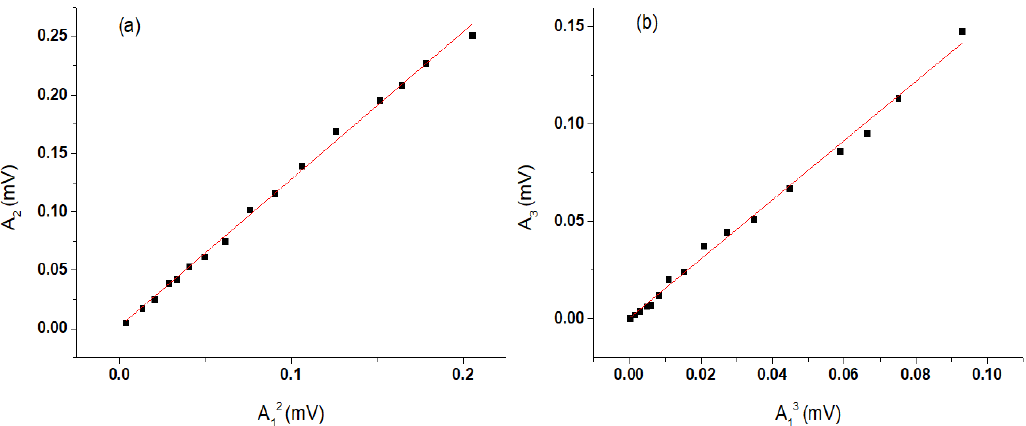
Figure 7. Long-term stability test of the measuring system at room temperature.